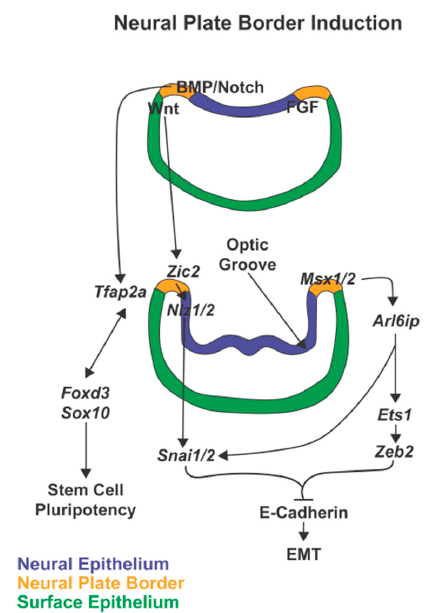
Figure 2. Neural plate border induction. In neural plate border induction, FGF followed by Notch and BMP signaling are expressed in the neural ectoderm while Wnt is expressed in the non-neural ectoderm. In the next phases of neurulation and optic groove formation, these signals then induce expression of the neural plate border specifiers, Msx1/2, Zic2, and Tfap2. These transcription factors, expressed within the neural plate border, trigger signaling cascades that maintain stem cell pluripotency and prepare the premigratory neural crest cells for epithelial-mesenchymal transition (EMT).